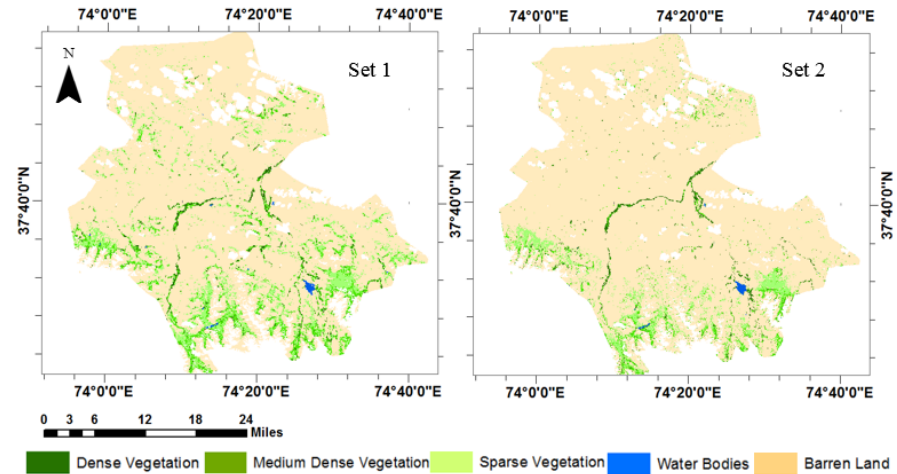
Figure 7. Map classifications showing the five landcover classes. Set 1 uses all object features with MDI, while Set 2 uses all object features without MDI.